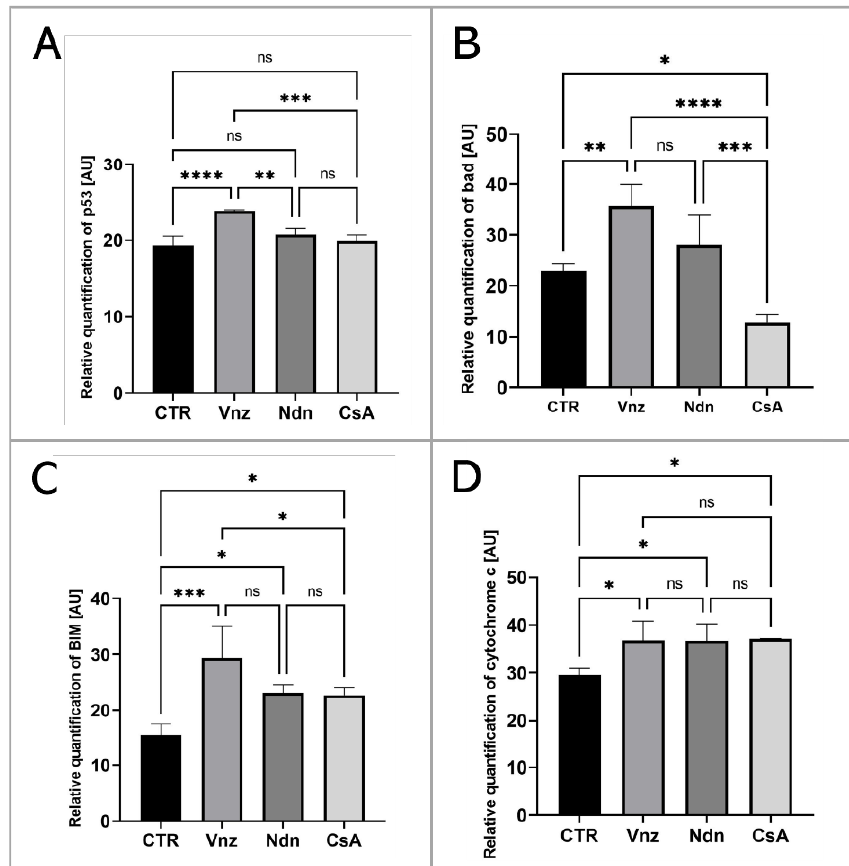
Figure 3. Analysis of the expression of proteins involved in the activation of the mitochondrial pathway of apoptosis at the level of total protein (apoptosis antibody array kit) in porcine COCs subjected to the IVM procedure using a 3D culture model (alginate capsules) in control cultures (CTR) or in experimental cultures: in the presence of vinclozolin (Vnz), nandrolone (Ndn) or cyclosporin A (CsA). The graphs show the relative content of p53 ( A ), bad ( B ), BIM ( C ) and cytochrome c ( D ) proteins obtained from measurements of the optical density of the spots representing a specific signal after normalization against the positive control. Results represent the mean with n = 5 ± standard deviation (SD); each “ n ” consisted of 200 COCs. Statistical analysis: homogeneity of variance—Brown–Forsythe test; normality of distribution—Bartlett’s test and one-way ANOVA followed by Dunnett’s post hoc test, * p < 0.05, ** p < 0.01, *** p < 0.001, **** p < 0.0001;